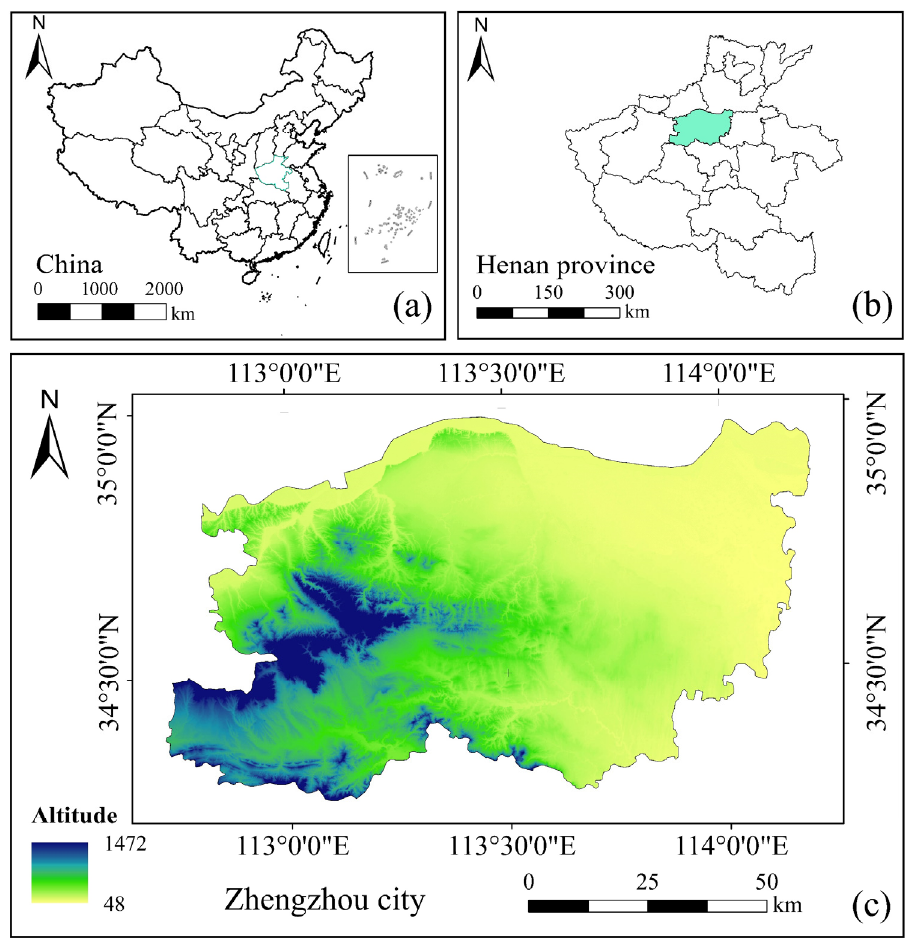
Figure 1. Geographic location ( a ), administrative boundaries ( b ), and topography ( c ) of Zhengzhou city.